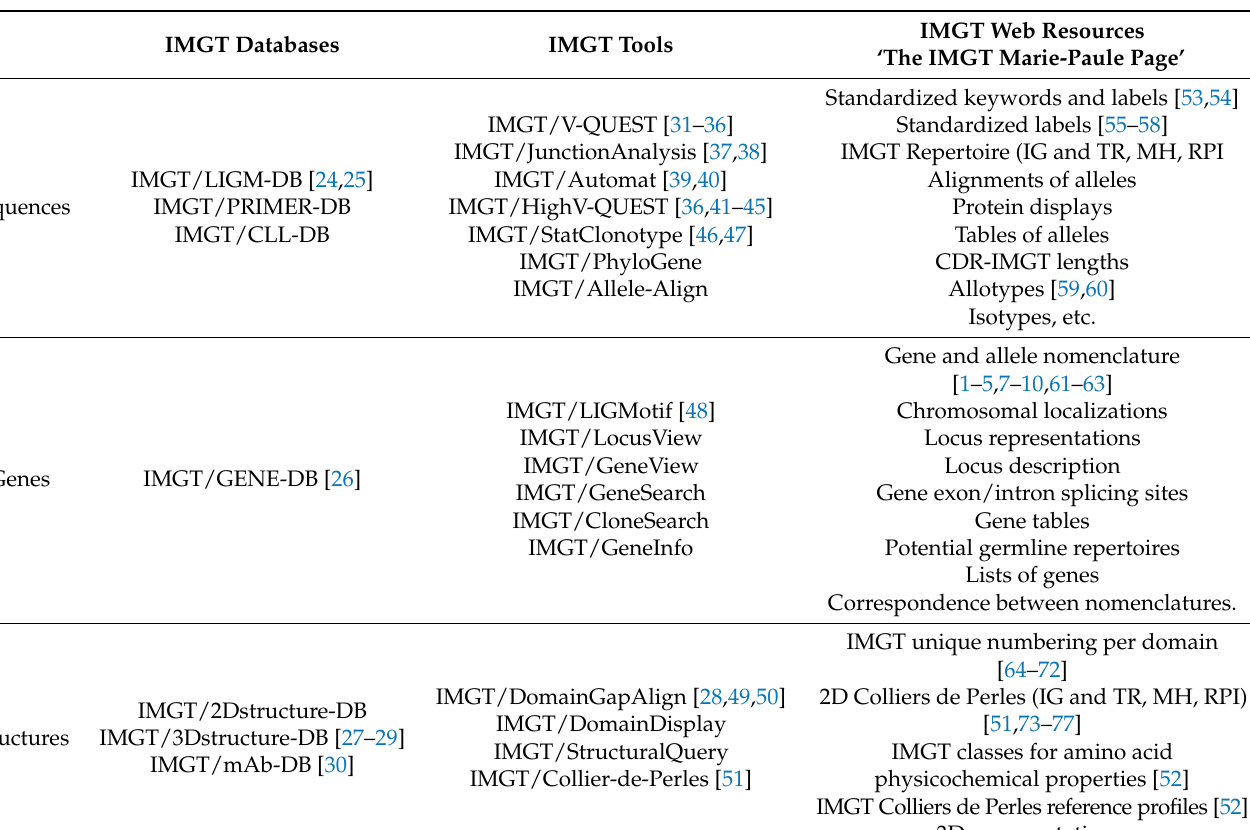
Table 1. The IMGT databases, tools and web resources (‘The IMGT Marie-Paule Page’) for sequences, genes and